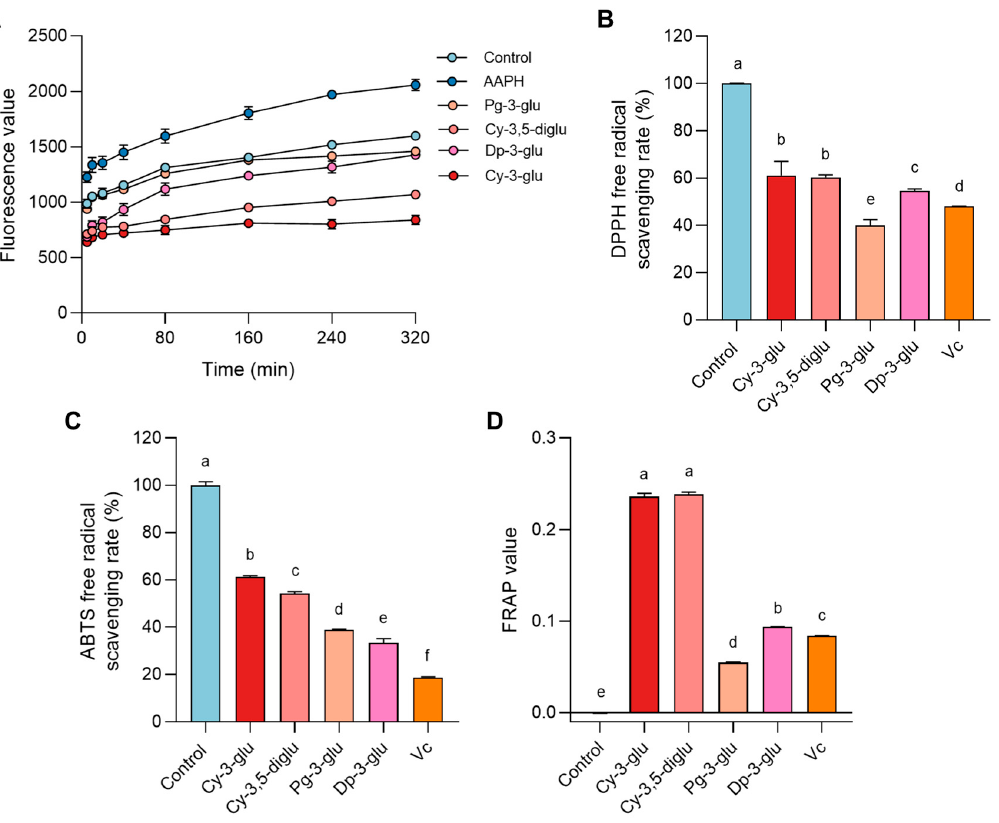
Figure 4. The antioxidant capacity of anthocyanin can improve cellular oxidative stress damage: ( A ) The change in ROS level after treatment with 160 µ M of AAPH and 50 µ M of anthocyanins, n = 5. Measurement of in vitro antioxidant capacity of 50 μ M of different anthocyanins. ( B ) DPPH, n = 3. ( C ) ABTS, n = 3. ( D ) FRAP, n = 3. All data were analyzed for differences by one-way ANOVA. Different letters indicated that there is a significant difference ( p < 0.05).